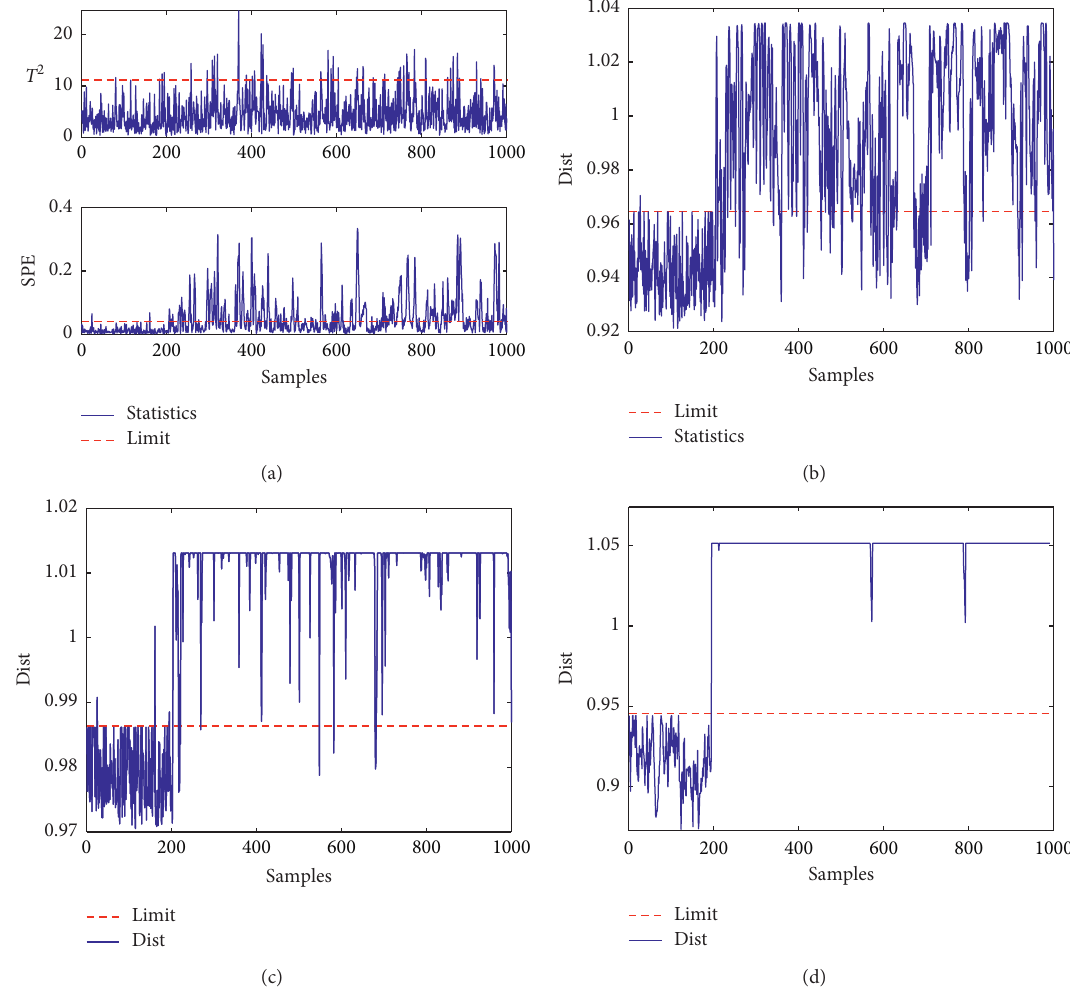
Figure 2: Monitoring results for fault 11 of Mode 1 by (a) KPCA, (b) conventional SVDD, (c) LDR-wSVDD, and (d)